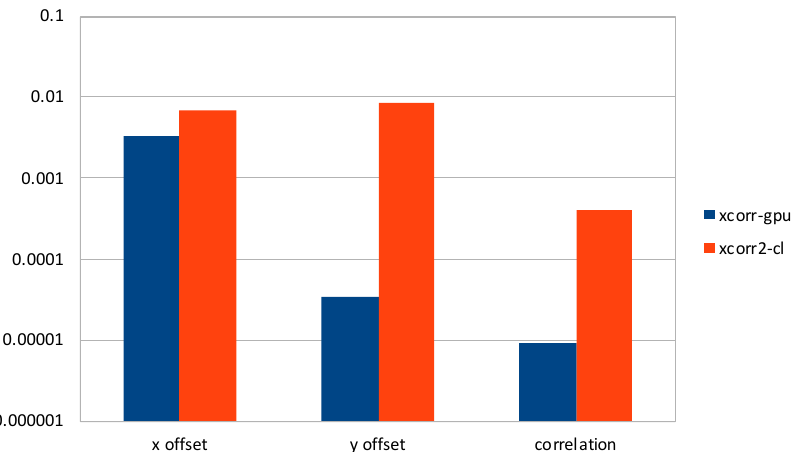
Figure 6. Comparison of average η 2 on selected datasets for xcorr-gpu and xcorr2-cl , in logarith- mic scale.